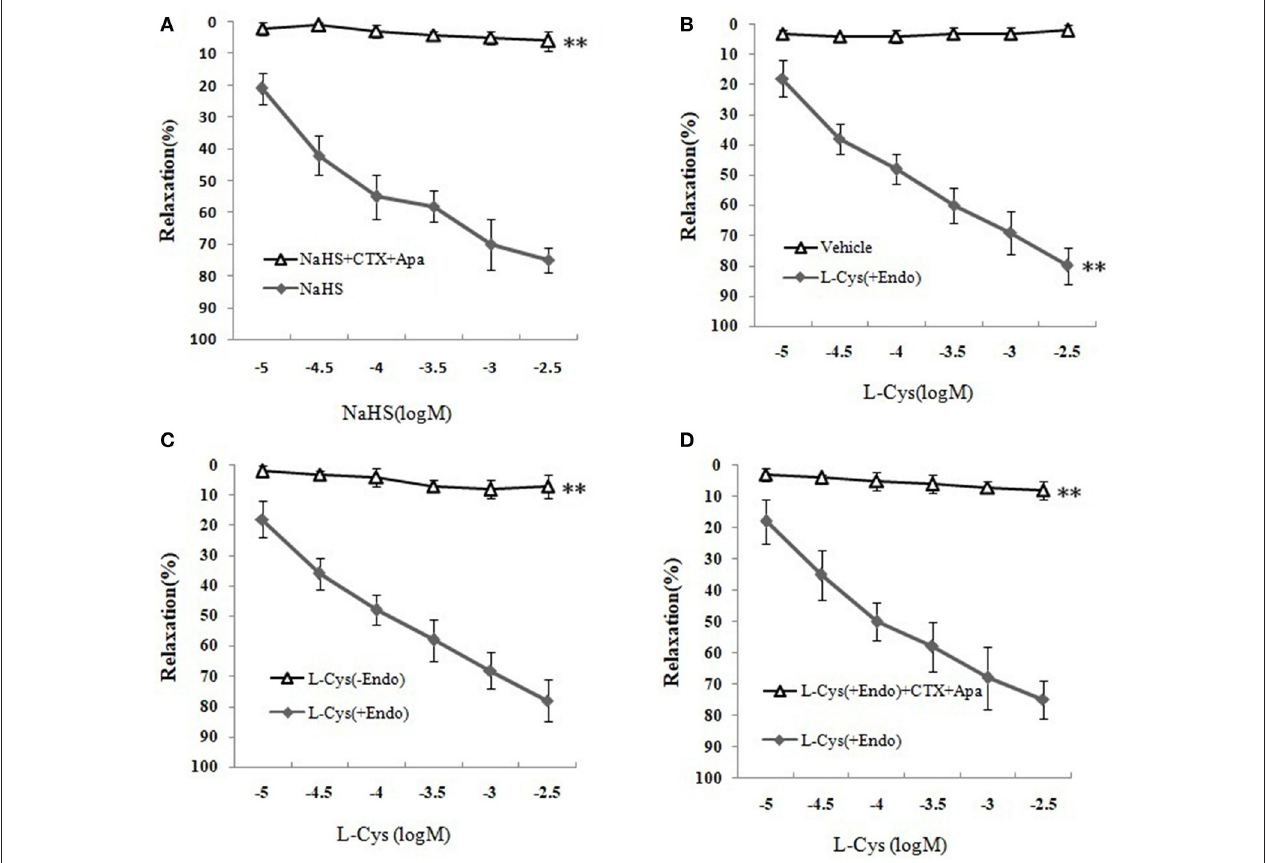
FIGURE 3 | Effects of K Ca channel blockers CTX and Apa on H 2 S-mediated relaxation in MCA of normal rats (mean ± SD, n = 8). (A) Effects of CTX and Apa on NaHS-induced relaxation. (B) Effect of L-Cys on relaxation in U46619-preconstricted rat MCA. (C) Effects of the endothelium removal on the L-Cys- induced